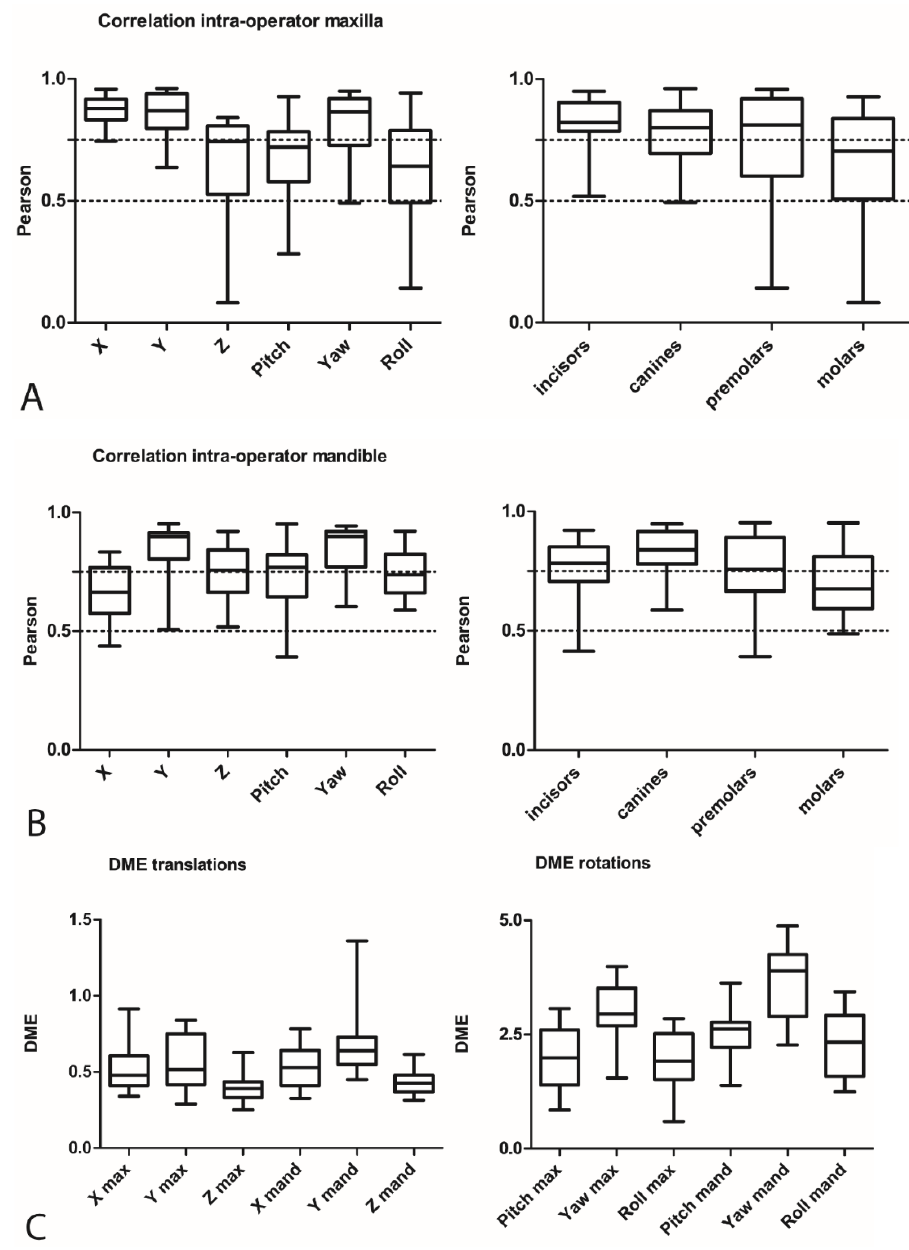
Figure 4. ( A ) Intra-operator correlations in the maxilla for translations, rotations, and tooth types. ( B ) Intra-operator correlations in the mandible for translations, rotations, and tooth type. ( C ) Intra- operator DME for all translational and rotational movements.